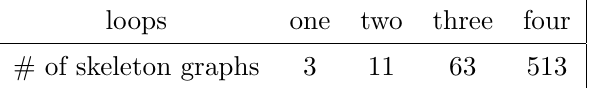
Table 1 . The number of skeleton graphs generated with Sage at each loop order. At four loops one can also draw two additional disconnected graphs, however they have to be discarded as they do not contribute to the connected